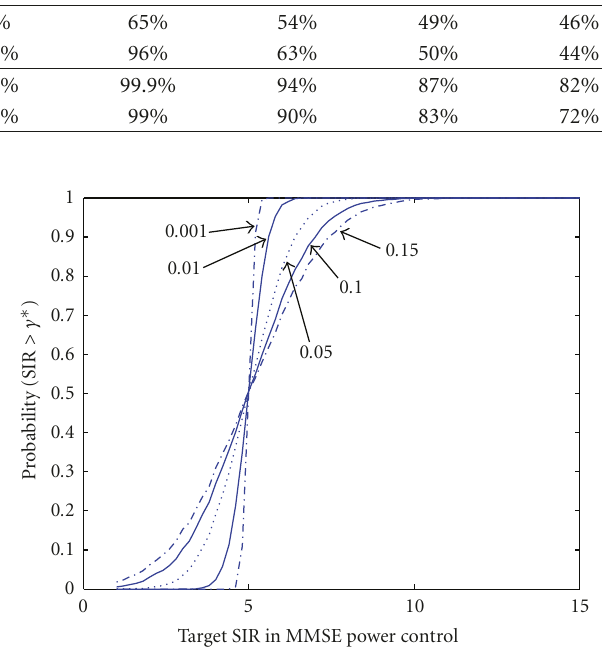
Figure 11: Downlink probability (SIR > γ ∗ ) versus TSIR for